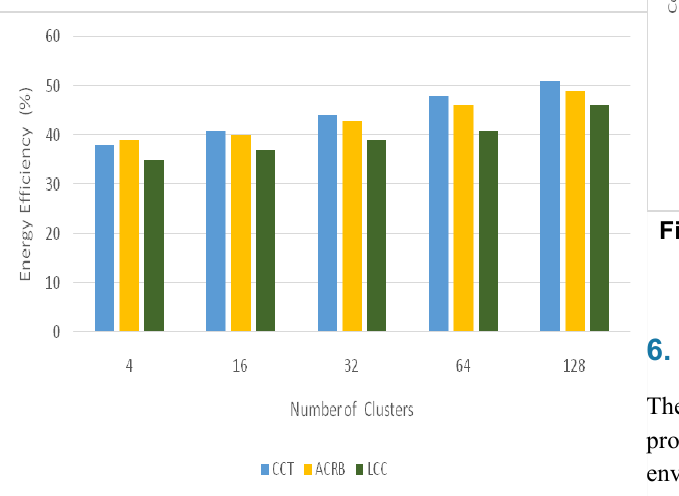
Figure 11. Energy Efficiency vs. Number of Clusters